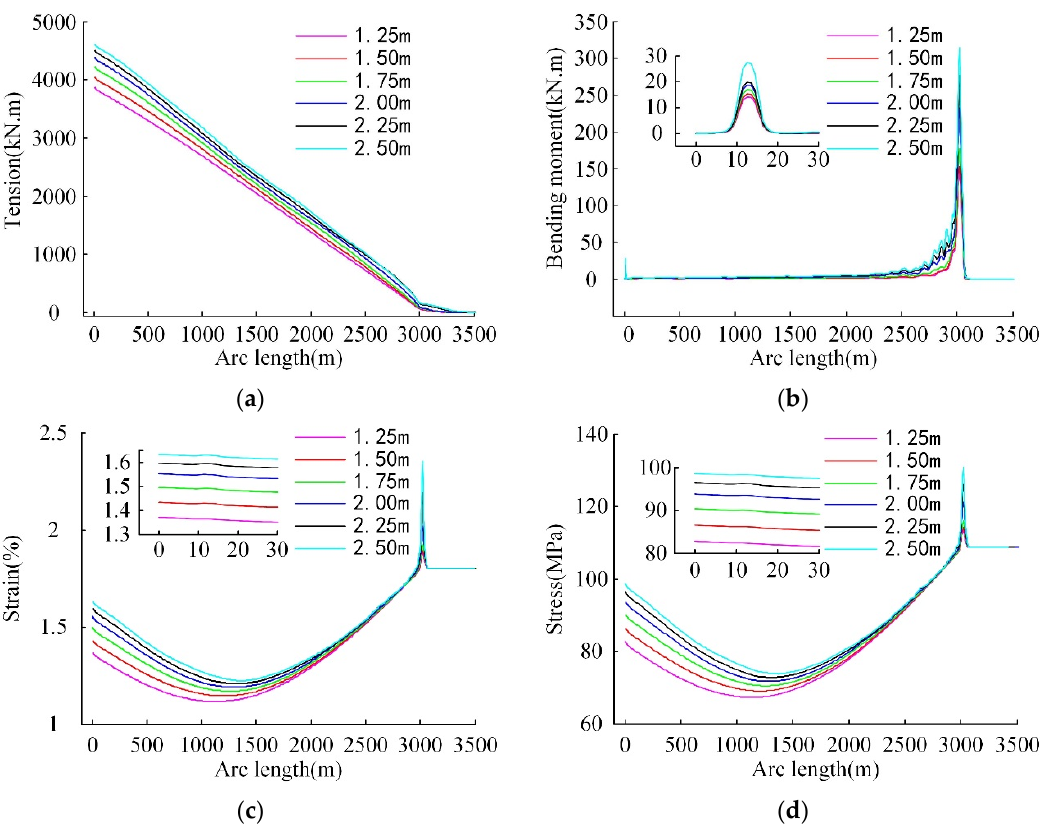
Figure 11. Effect of wave height on pipeline dynamic responses: ( a ) Axial tension; ( b ) Bending moment; ( c ) Strain; ( d ) Stress.